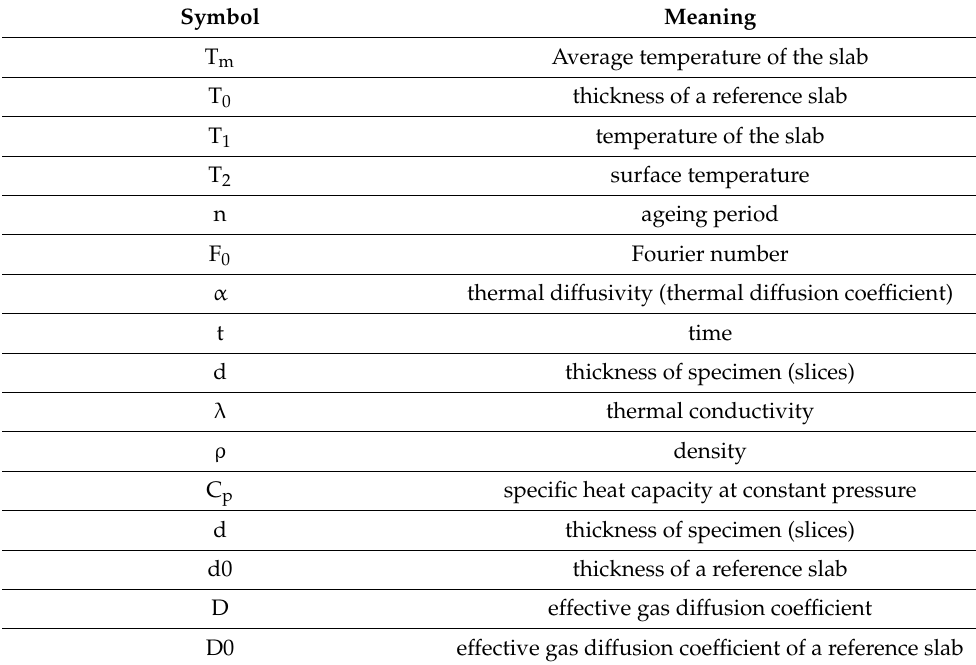
Table 3. Definition of variables in